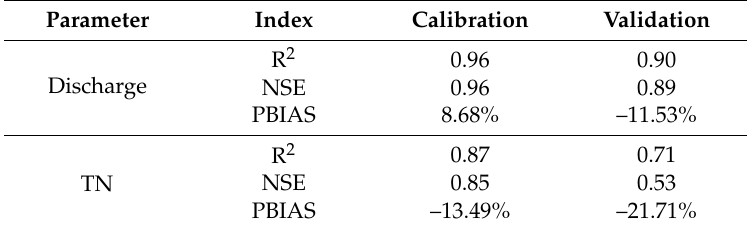
Table 1. Evaluation results of the discharge and TN